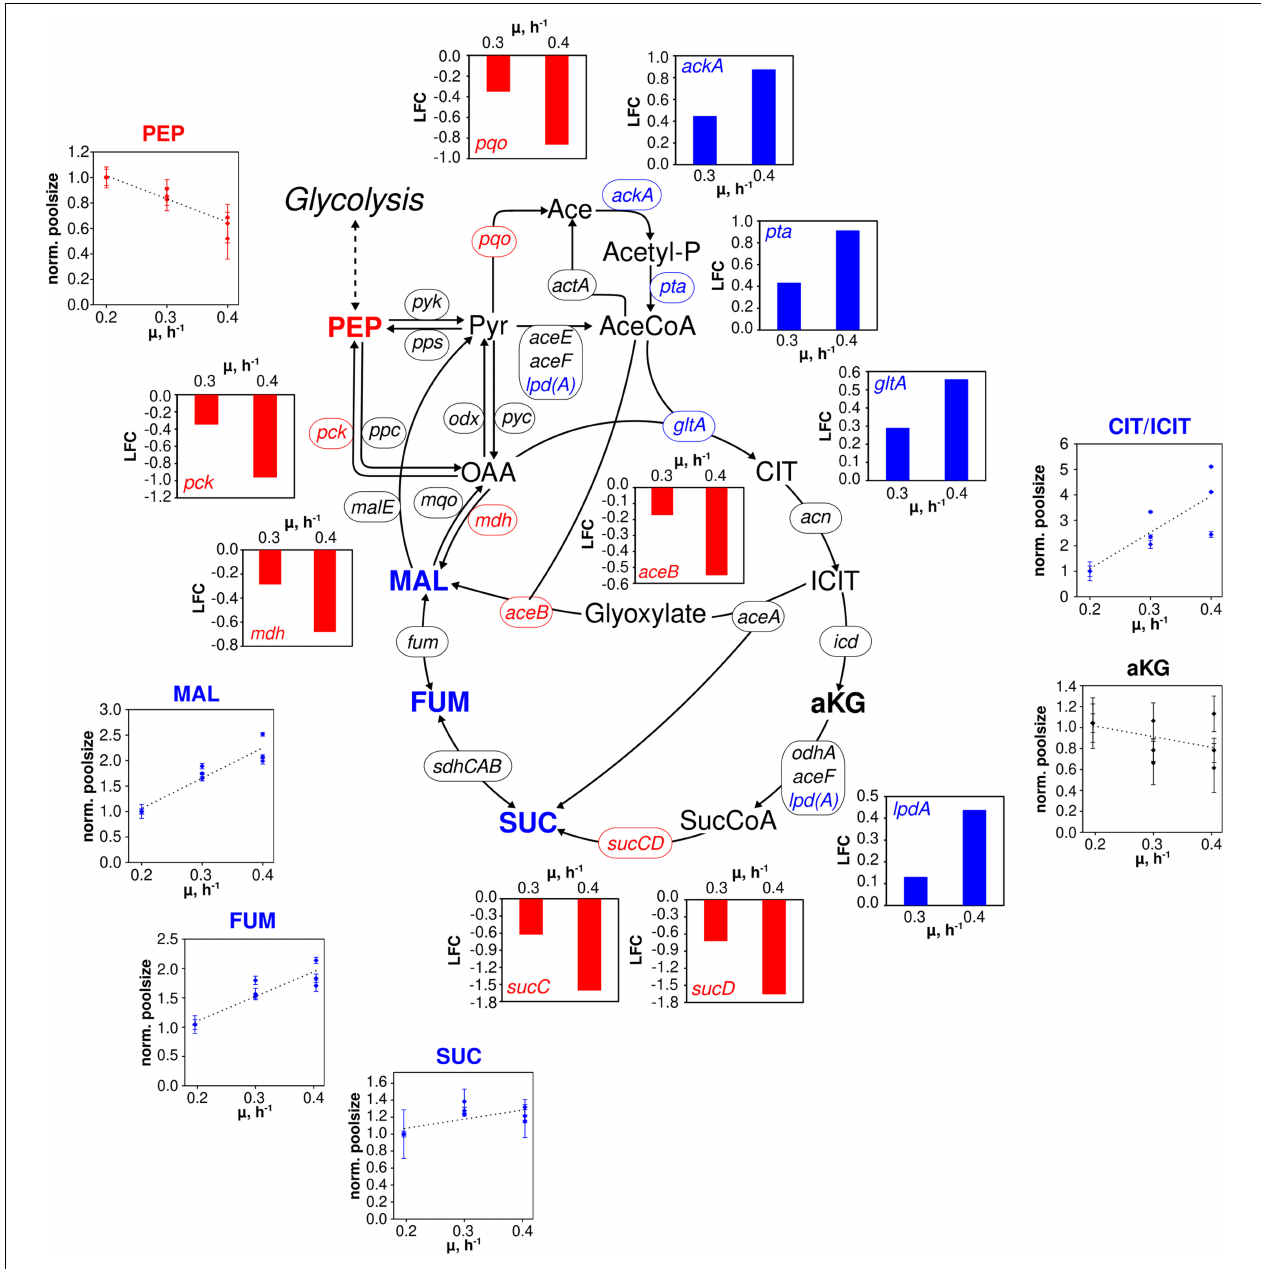
FIGURE 4 | Metabolic and transcriptional response in the TCA cycle of C. glutamicum WT to different growth rates ( µ = 0.2, 0.3, 0.4 h - 1 ) installed in three independent chemostat processes. Depicted intracellular metabolite concentrations were normalized to respective values determined at µ = 0.2 h - 1 ; values represent the mean of three technical replicates ± standard deviation. Gene expression was normalized to the expression level determined at µ = 0.2 h - 1 and is depicted as log fold change (LFC); genes are shown in italic writing. Color code: red, decreasing concentration/expression; blue, increasing